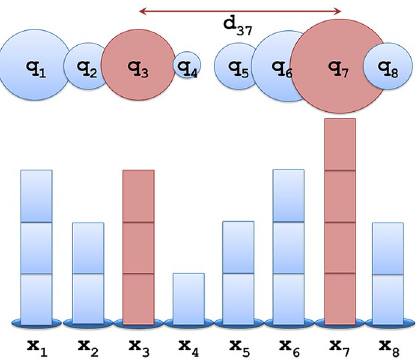
Figure 1. Example of the electrostatic graph (ESG) algorithm conceptualization. The volume of electrical charge ( q i , i = 1,..,8) in each node is shown proportionally to the node size ( x i , i = 1,..,8) of the